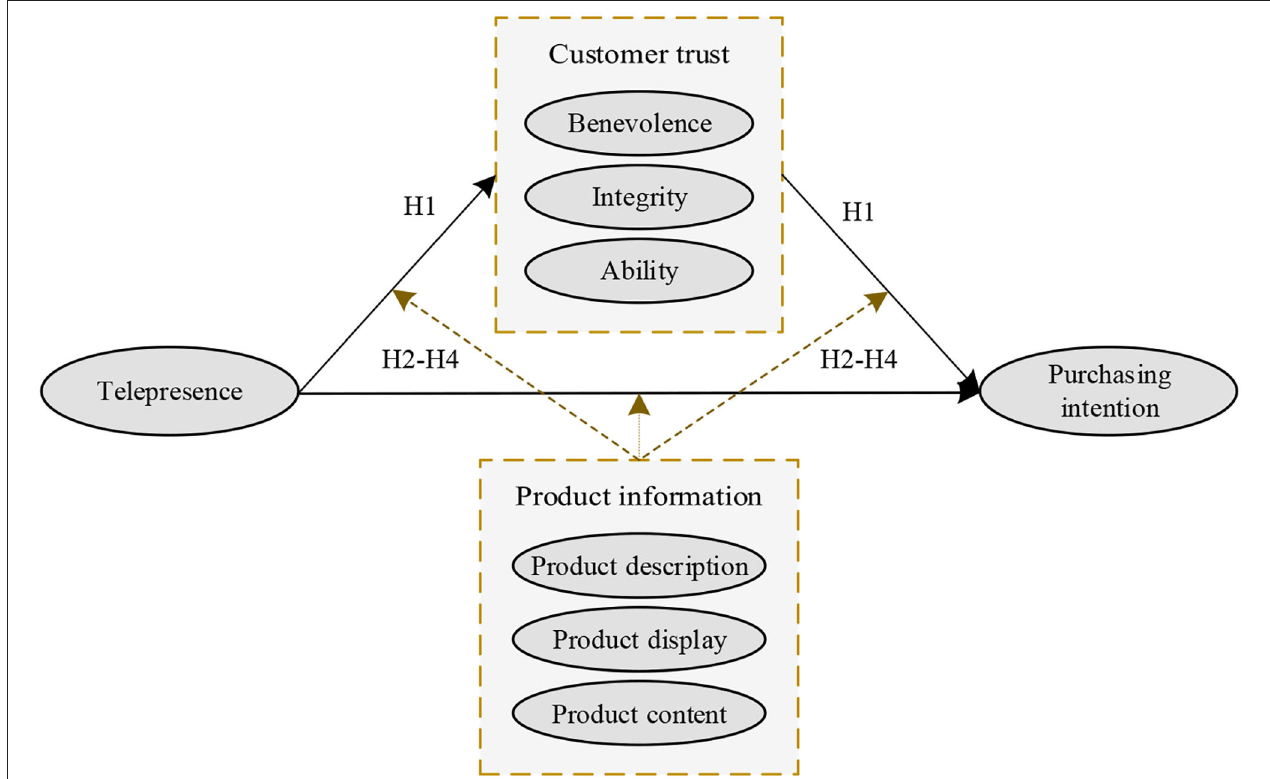
FIGURE 1 | Research model of this